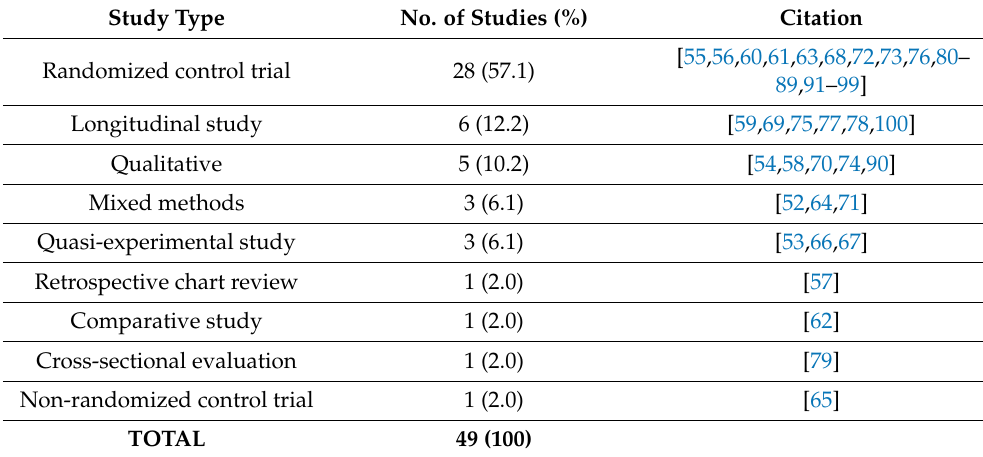
Table 3. Study design summary.